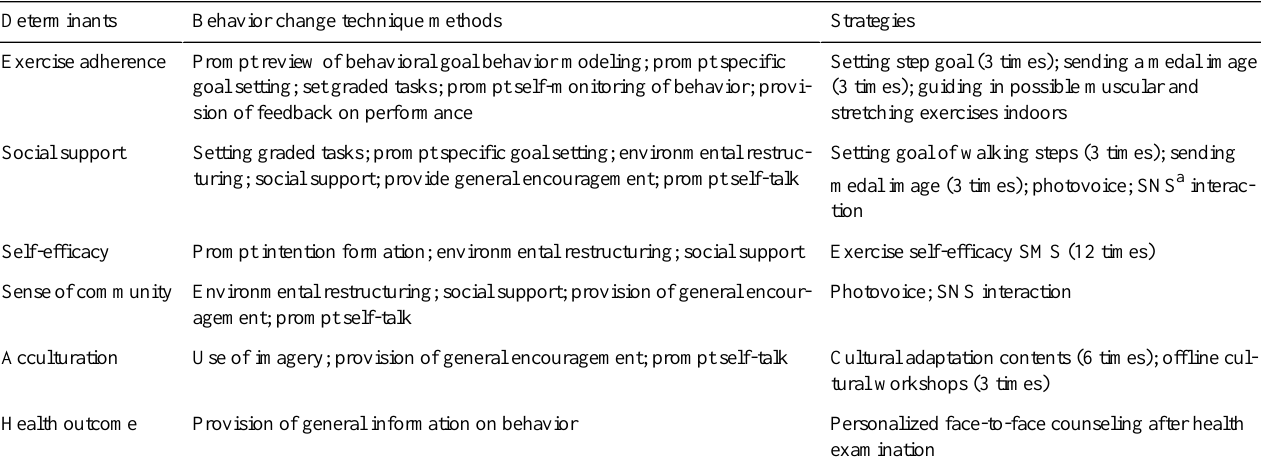
Table 1. Behavior change theory methods and practical strategies for the living lab for a mobile-based health program. StrategiesBehavior change technique methodsDeterminants